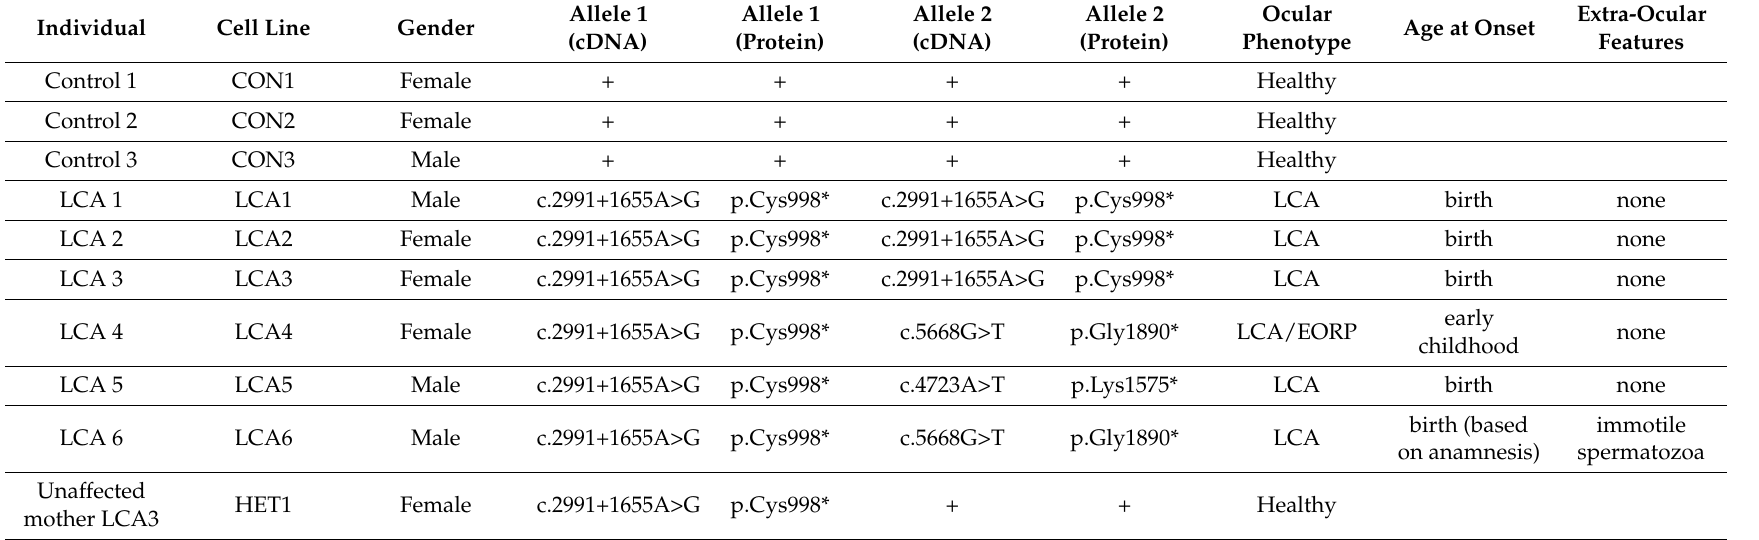
Table 1. Genetic and clinical information of the